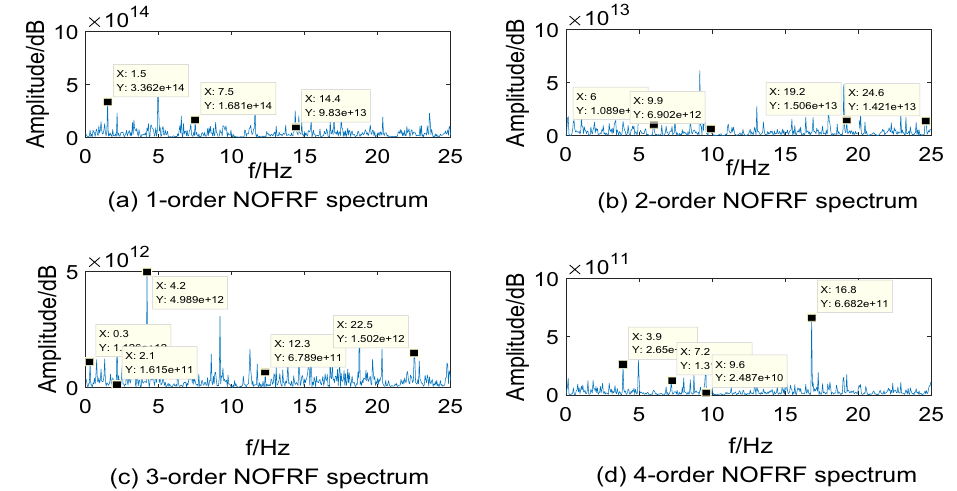
Figure 8. NOFRF spectrum of first 4-order in R3.